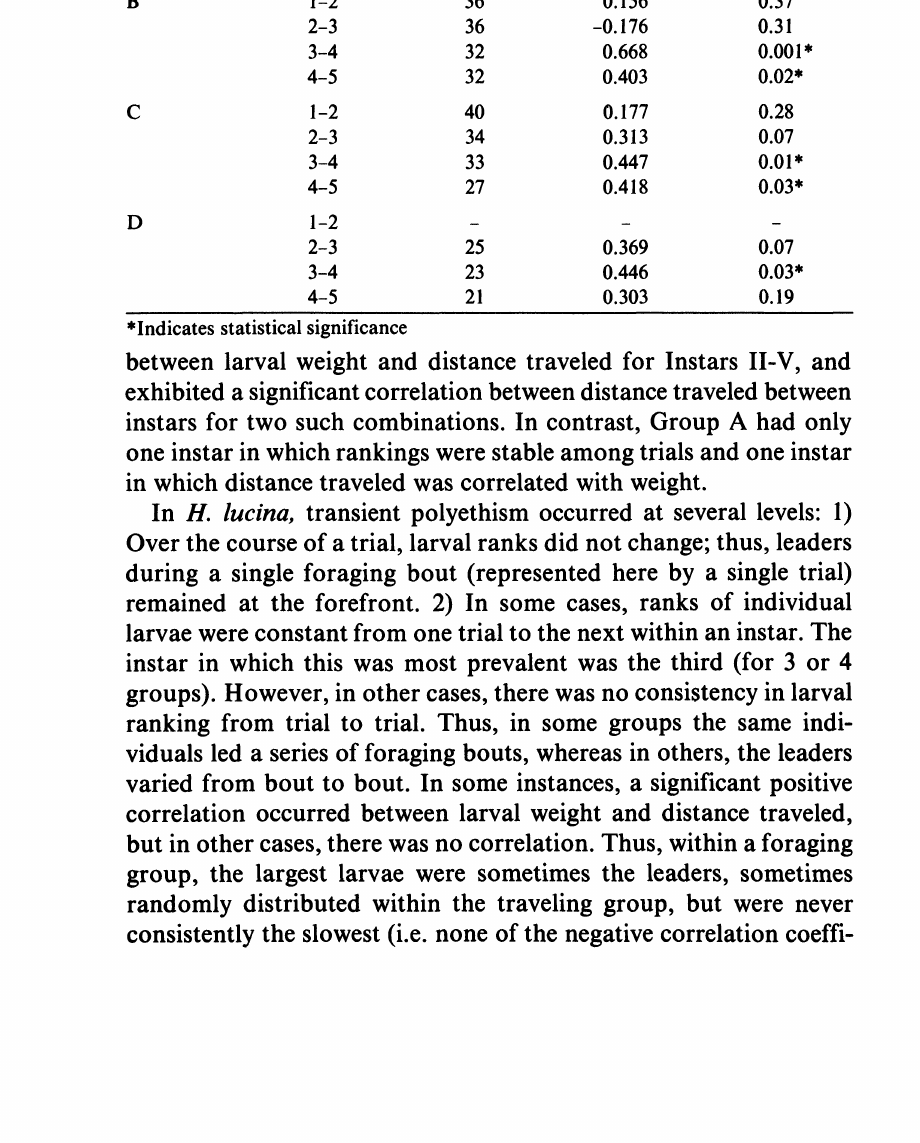
Table 4. Relationship between instars for total distance traveled by marked individuals in groups. Spearman rank coefficients (rs) and probability (P) at a 0.05 are